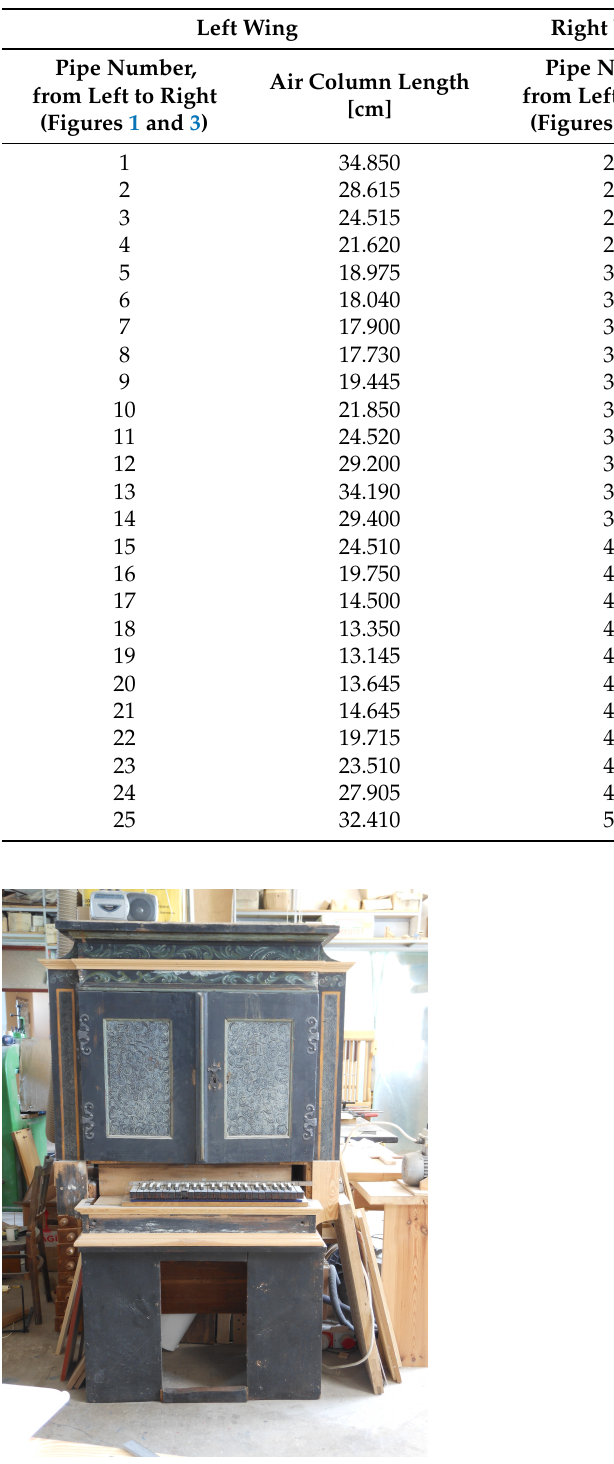
Table 1. Measurements of the “virtual” air column length in the pipes of the chest organ door